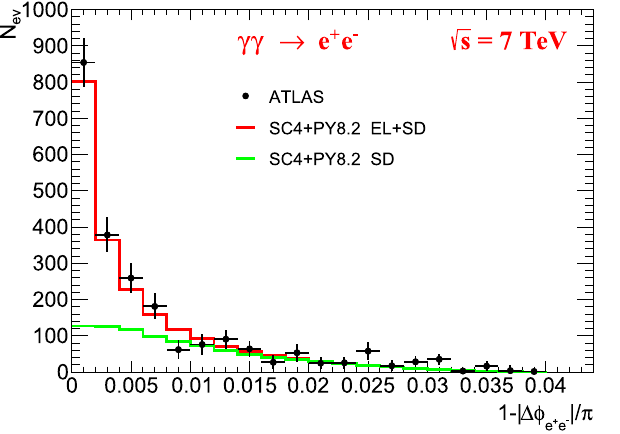
Fig. 4 Comparison of SuperChic 4 + Pythia 8.2 predic- tions for the dilepton acoplanarity distribution compared to the ATLAS √ s = 7 TeV, within the corresponding experimental fidu- data [30] at cial region, and with a rapidity veto applied on tracks in the central